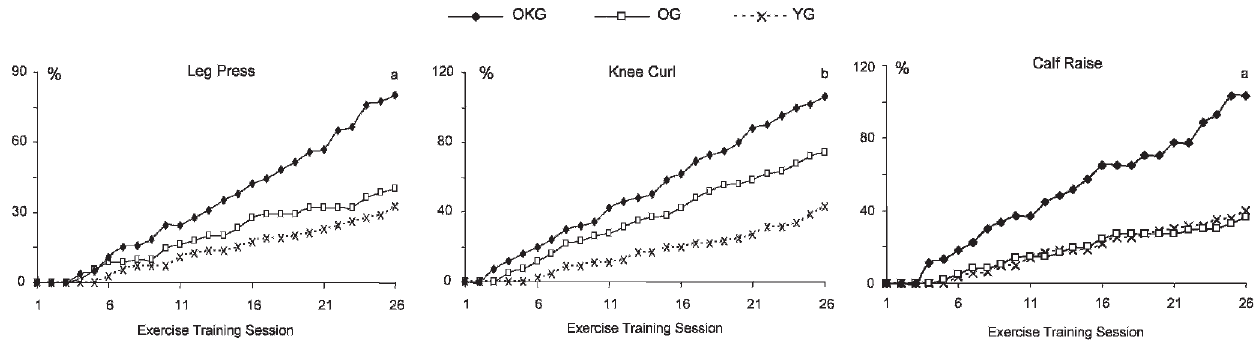
Figure 2 - Relative workload increase curves. OKG: Older knee osteoarthritis and total knee arthroplasty group. OG: Older control group. YG: Young control group. a denotes significant difference from OKG - OA ( p , 0.05). b denotes significant difference from YG ( p ,